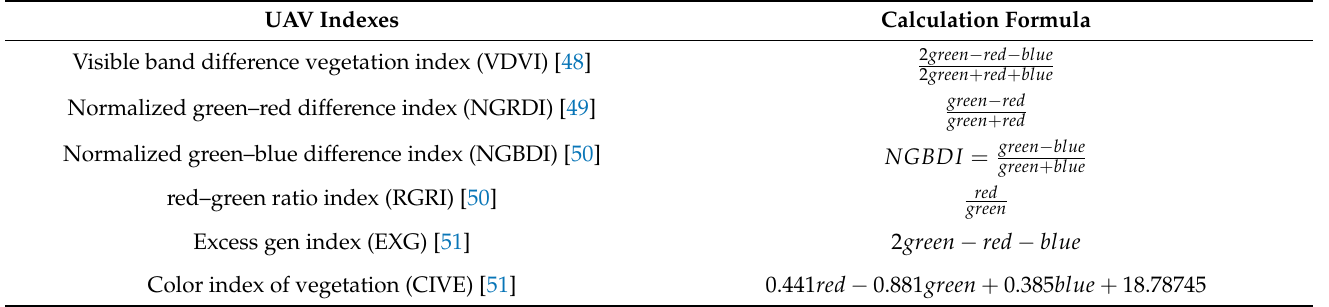
Table A2. Calculation formulas of UAV vegetation indices.